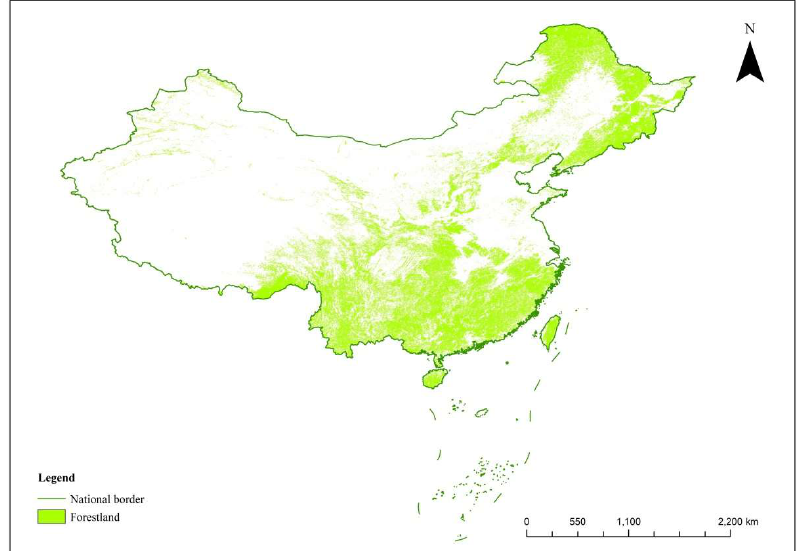
Figure 6. Forestland distribution of China.